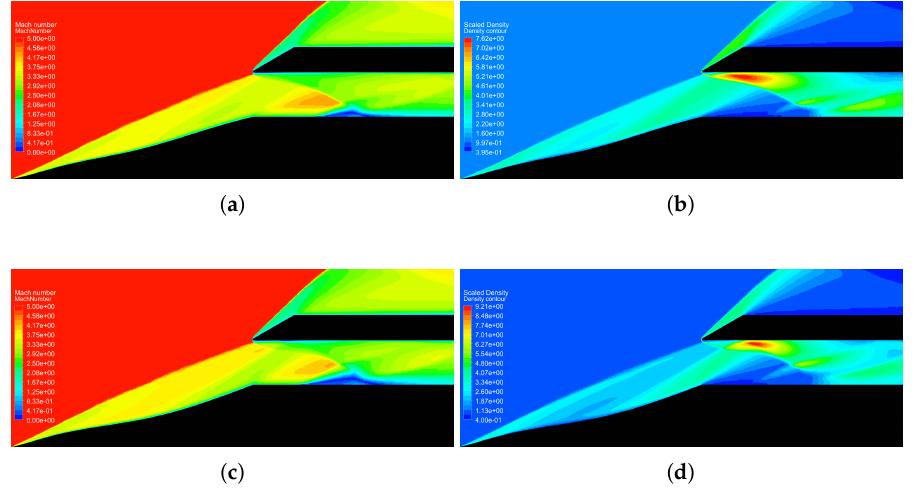
Figure 10. Mach number and scaled density contours for optimized f 1 / f 2 solutions. ( a ) Mach number contour C d —optimum; ( b ) Density contour C d —optimum; ( c ) Mach number contour SPR —optimum; ( d ) Density contour SPR